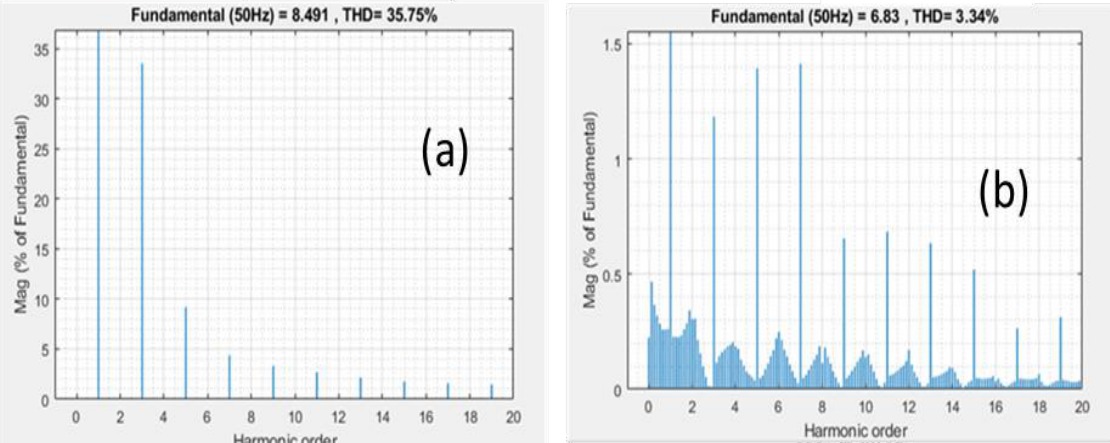
Figure 16. ( a ) Harmonics without control signal. ( b ) Harmonics with a control signal.